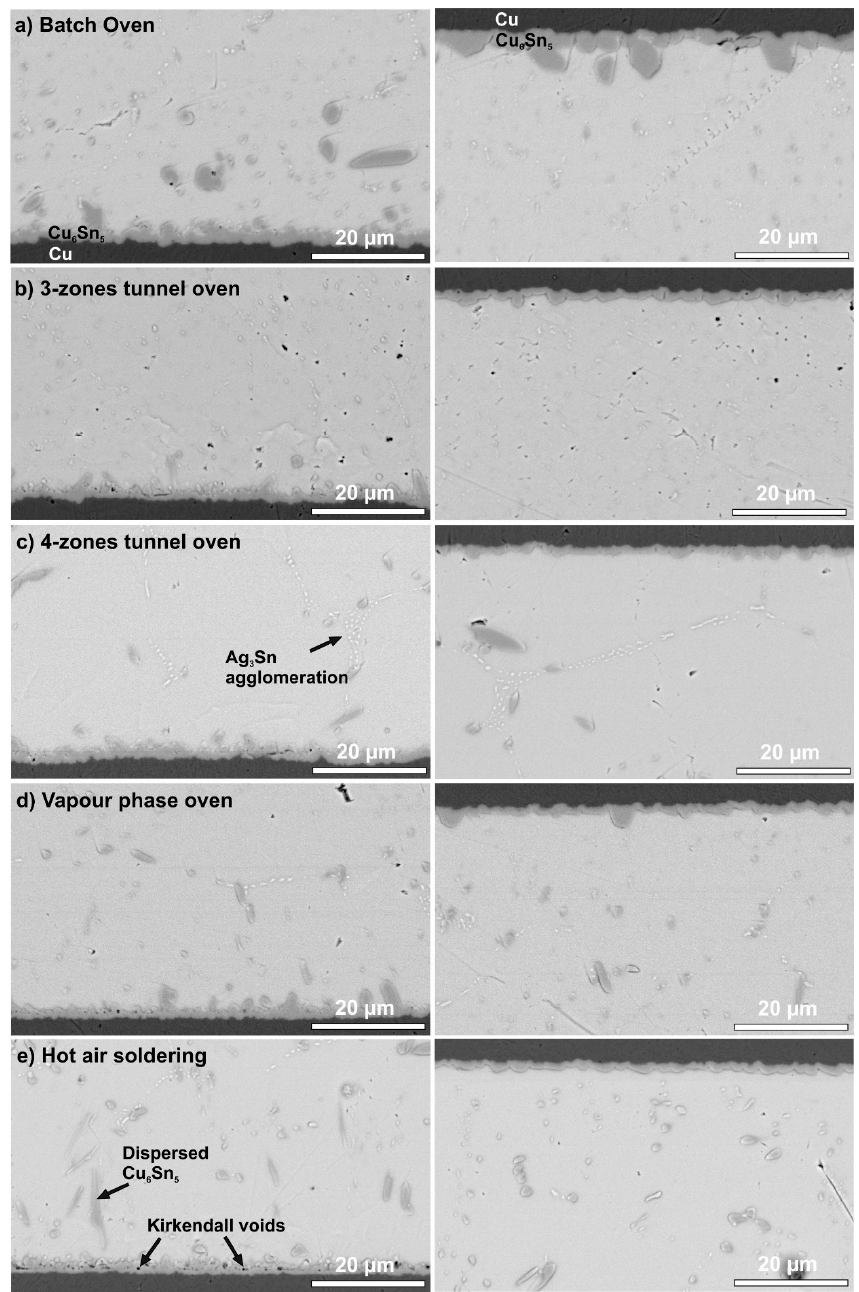
Figure 10. SEM micrographs of the solder joints under the IGBT: (right bottom side of the solder joint, left upper side of the solder joint): ( a ) batch oven, ( b ) 3-zones tunnel oven, ( c ) 4-zones tunnel oven, ( d ) vapour phase oven, ( e ) hot air soldering.